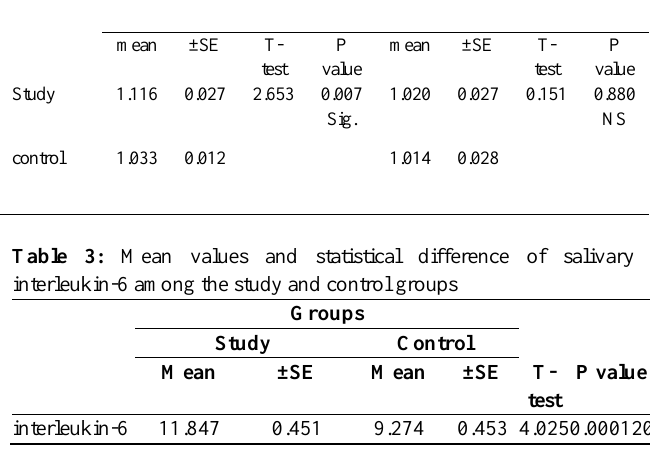
Table 4: Correlation between periodontal parameters